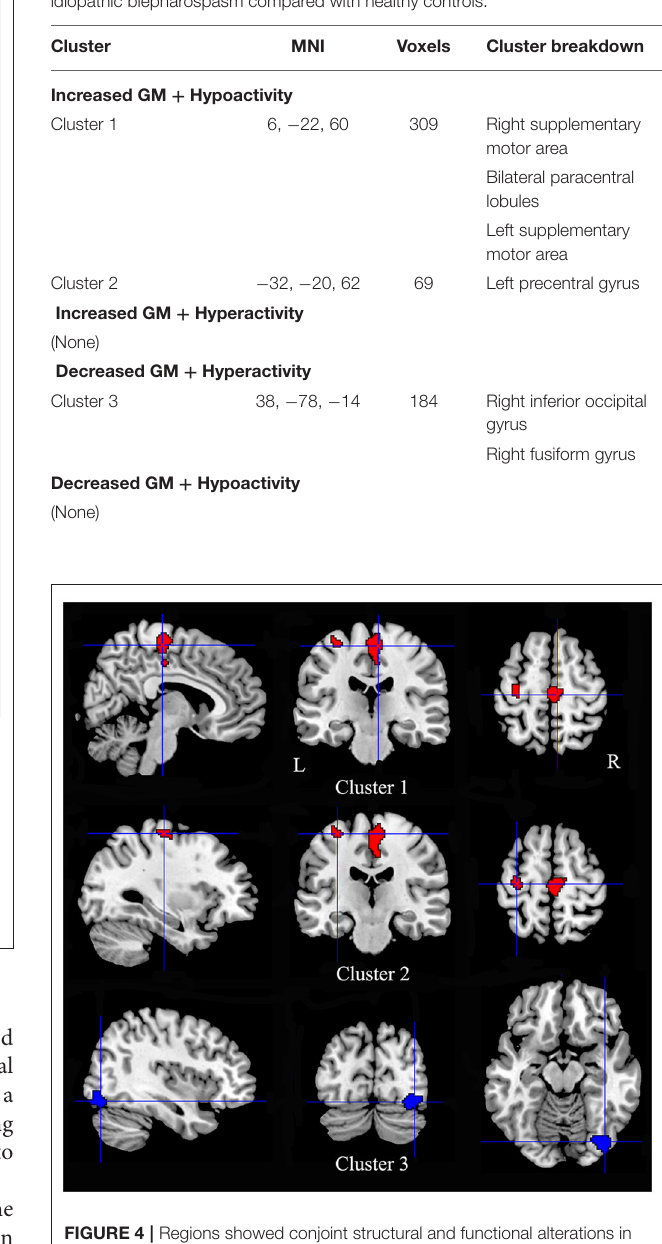
memory, visuospatial processing and emotion processing